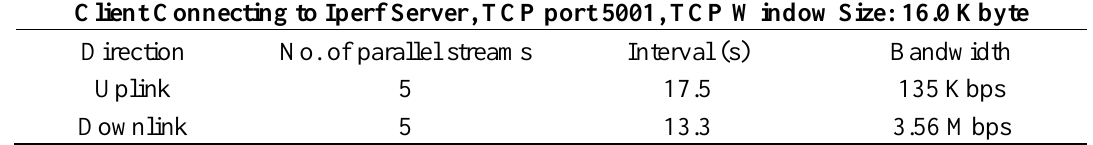
Table 5. Throughput